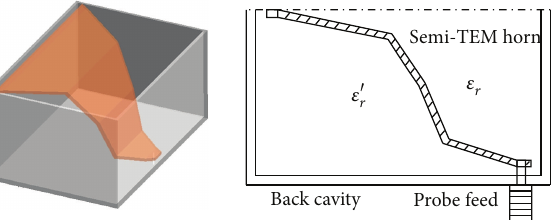
Figure 11: Experimental circuit of partial discharge.